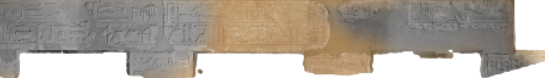
Figure 7 . Capture of the cloud point from 12 archive photographs.